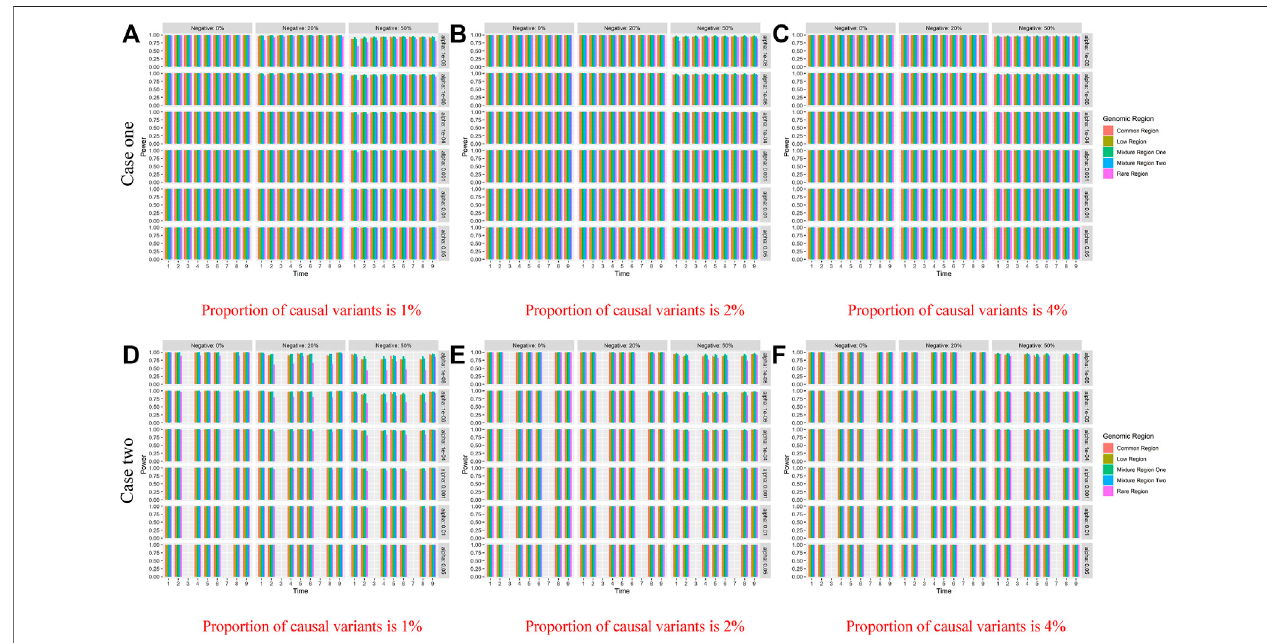
FIGURE 3 | Power of linkage disequilibrium ’ s case one and case two based on LFDAT for the fi ve gene regions when c is 3, and sample size is 2000. The (A – C) denotes the power results of case one. The (D – F) denotes the power results of case two. The time effect function is θ ( t ) (cid:2) 2 + 2sin ( π t /12 ) for case one, and θ ( t ) (cid:2) 2 + 2sin ( π t /2 ) forcasetwo.Caseone: (A) Proportionofcausalvariantsis1% (B) Proportionofcausalvariantsis2% (C) Proportionofcausalvariantsis4%.Case two: (D) Proportion of causal variants is 1% (E) Proportion of causal variants is 2% (F) Proportion of causal variants is 4%. Note: The r 2 measure of linkage disequilibrium is 0.25 to 0.64; Common region denotes gene regions only with common variants, Rare region denotes gene regions only with rare variants, Low region denotesgeneregionsonlywithlow-frequencyvariants,Mixtureregiononedenotesgeneregionswith20%ofcommonvariantsand80%ofrarevariants,andtheMixture region two denotes gene regions with 80% of common variants and 20% of rare